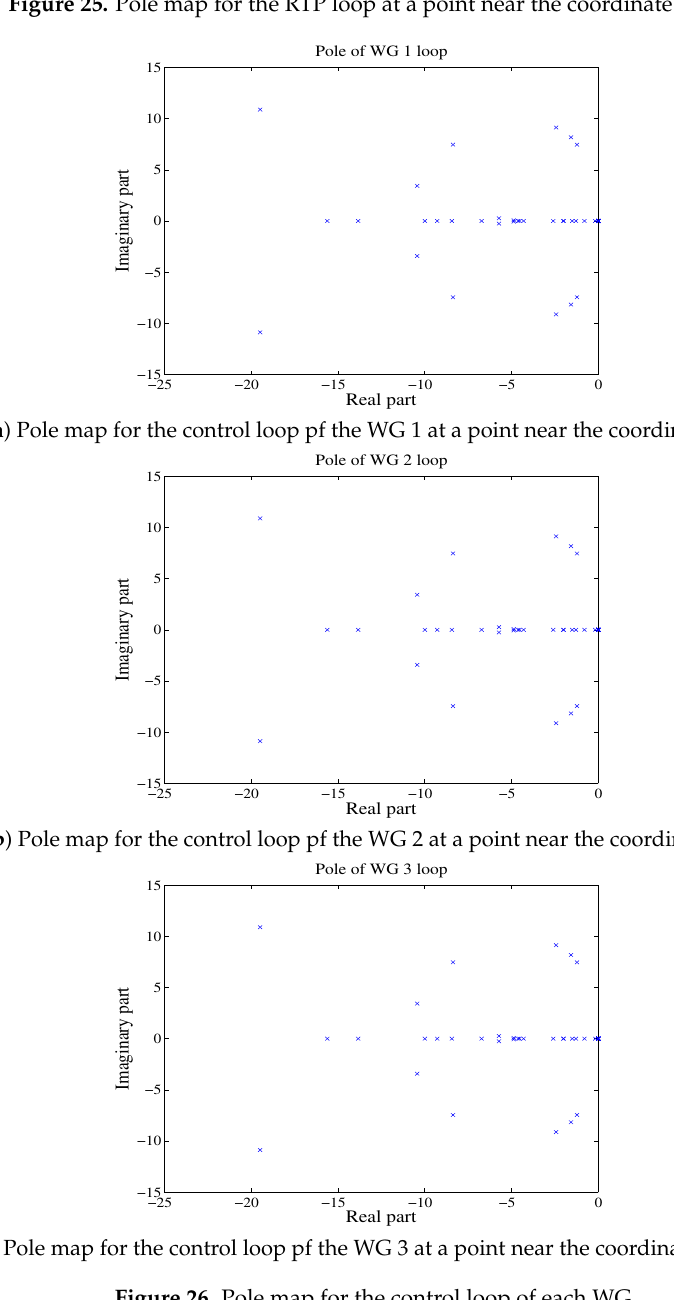
Figure 26. Pole map for the control loop of each WG.